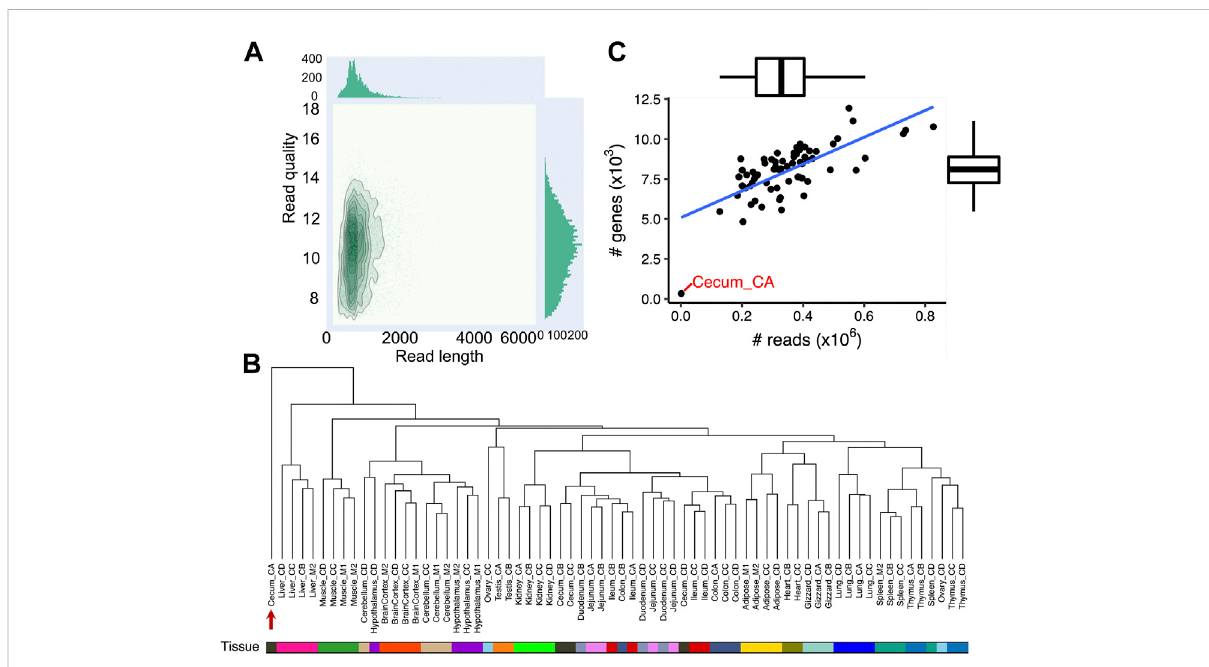
FIGURE 1 Datasummaryof68chickenNanoporelong-readtranscriptomedatasets. (A) Bivariateplot(DeCosteretal.,2018)depictingreadlength(x-axis) andquality(y-axis)ofNanoporelong-readtranscriptomereads (B) Hierarchicalclusteringof68chickenNanoporelong-readtranscriptomesamples used in this study. The dendrogram is built based on gene expressions quanti fi ed with transcripts per million (TPM ≥ 0.1). The distance between individuals is indicated by 1-r, where r is the Pearson correlation coef fi cient. The red arrow indicates sample Cecum_CA, which did not cluster with other cecal samples. (C) Correlation between the number of sequencing reads (x-axis) and the number of expressed genes (y-axis, TPM > 0.1). The Pearson ’ s correlation is 0.71 ( p = 1.30 × 10 − 11